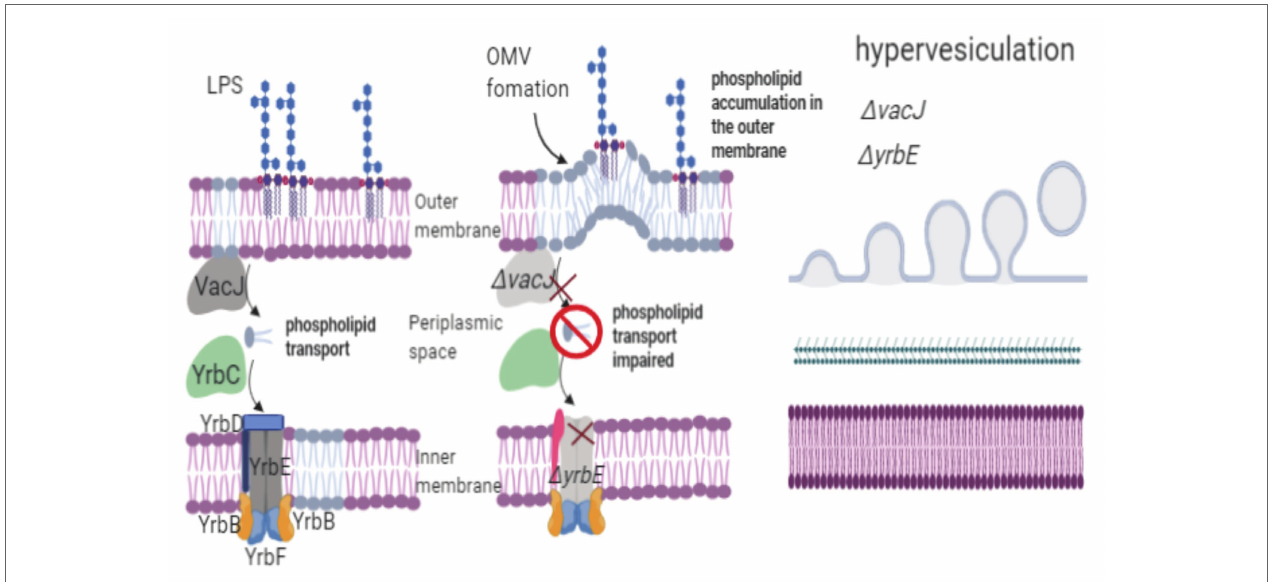
FIGURE 3 | Phospholipid transport regulates OMVs biogenesis. H. influenzae vacJ and yrbE mutants show a hypervesiculation phenotype because of the accumulation of phospholipids in the outer membrane. The vacJ and yrbE genes are involved in retrograde transport, maintaining membrane asymmetry. To trigger vesicle formation in the outer membrane, the transport of phospholipids from the inner membrane to the outer membrane should be significantly faster than phospholipid transport from the outer membrane to the inner membrane. Disorganization in phospholipid transport leads to the accumulation of phospholipids in the outer membrane, provoking OMV